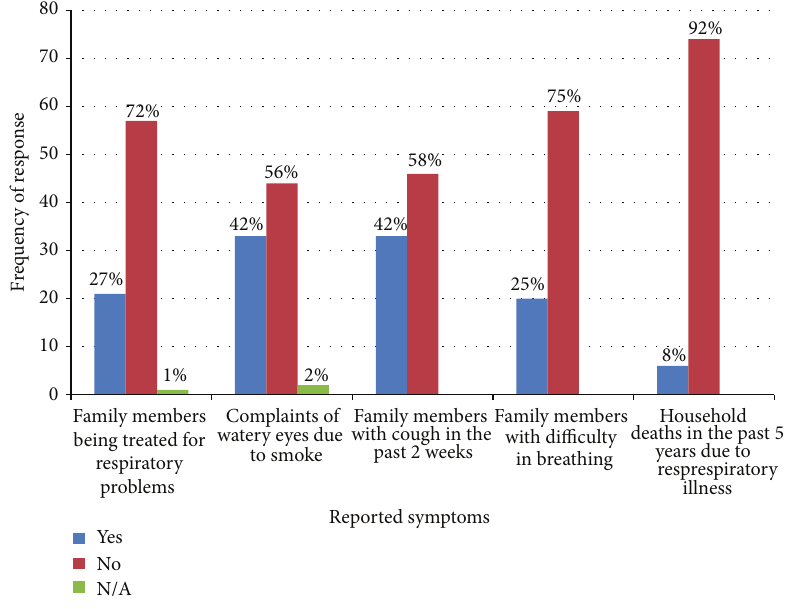
Figure 2: Summary of reported respiratory